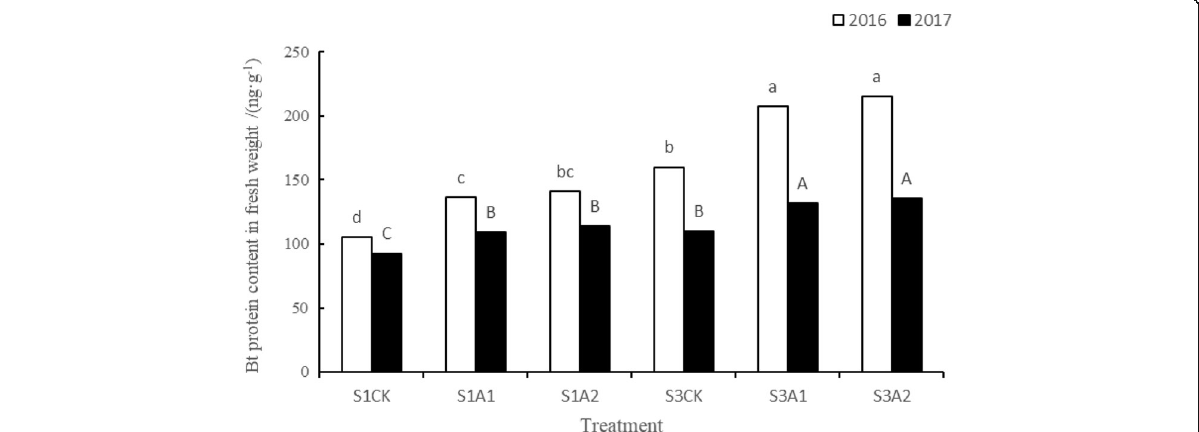
Fig. 1 The effect of application of 5 amino acids and 21 amino acids on flower Bt protein contents at flowering period in Bt cotton Sikang1(S1) and Sikang3 (S3). A1, A2, CK represented 5 amino acids treatment, 21 amino acids treatment, and the control, respectively. Differences between treatments within the same year labeled by the same letter are statistically not significant (LSD test at 0.05 significance level)